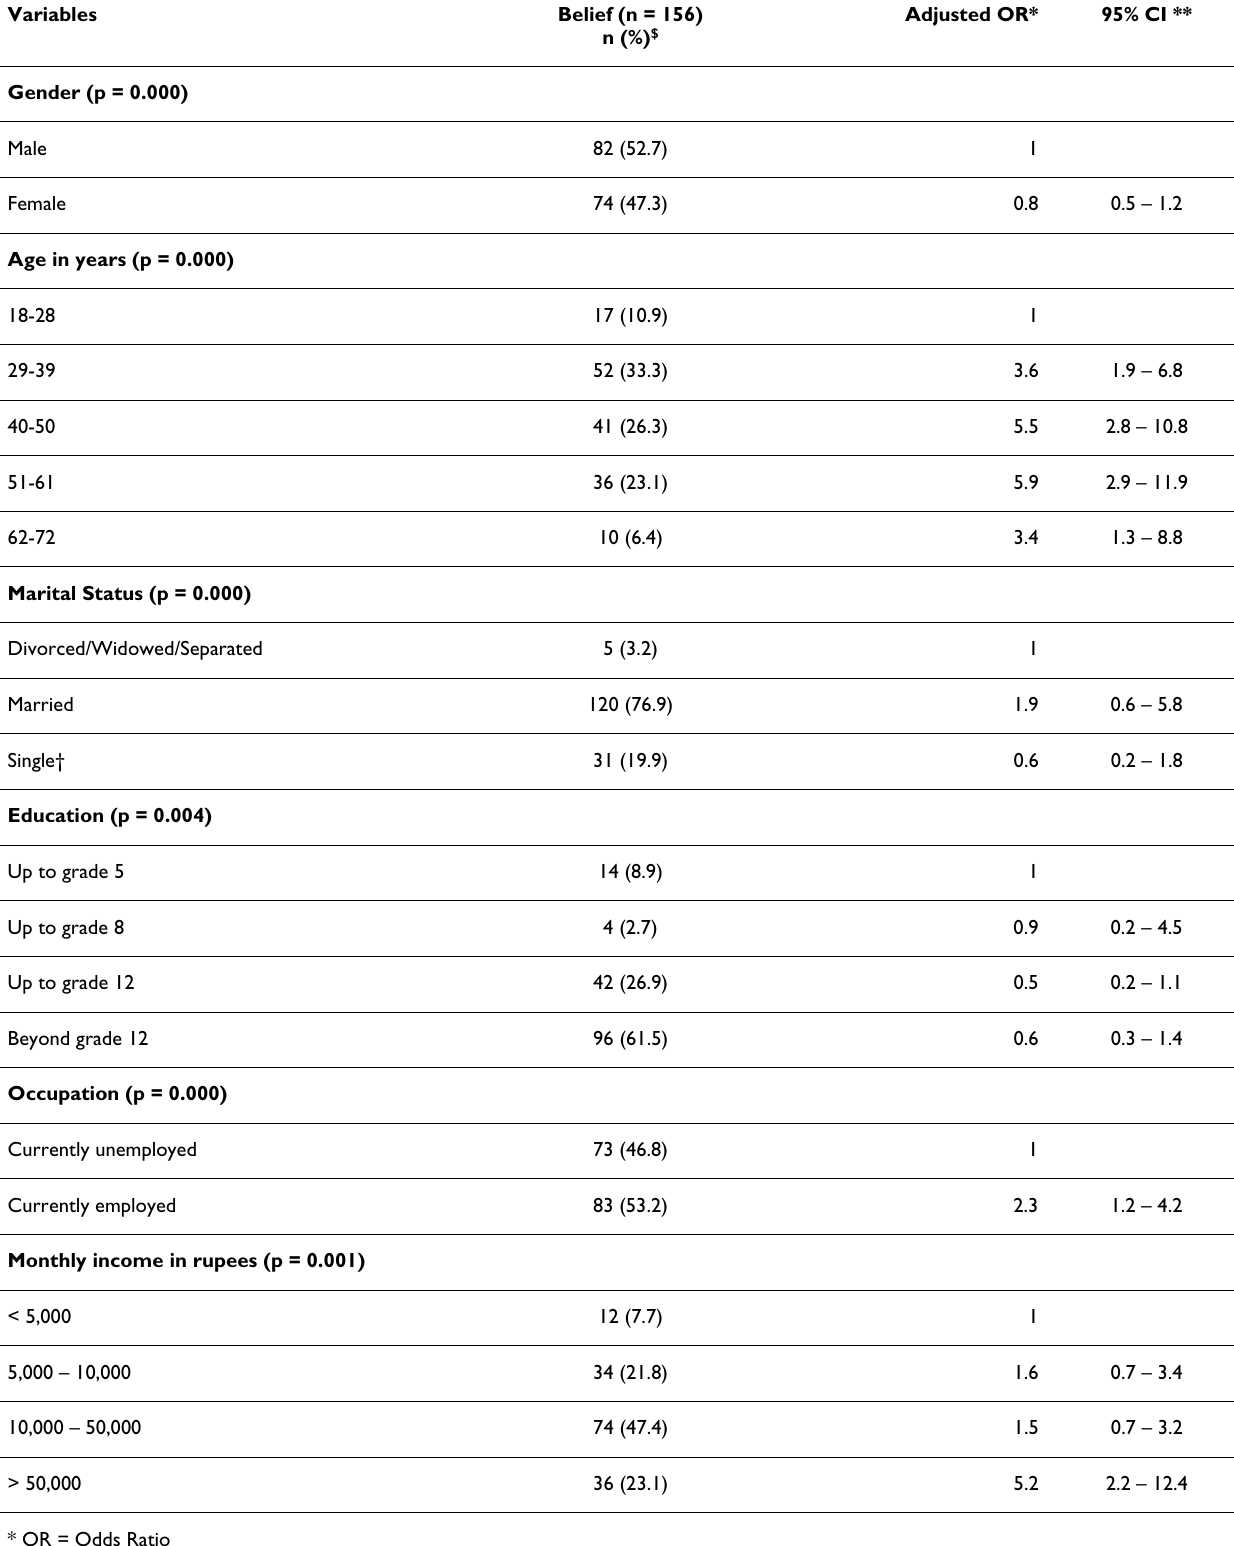
Adjusted OR* 95% CI ** n (%) $